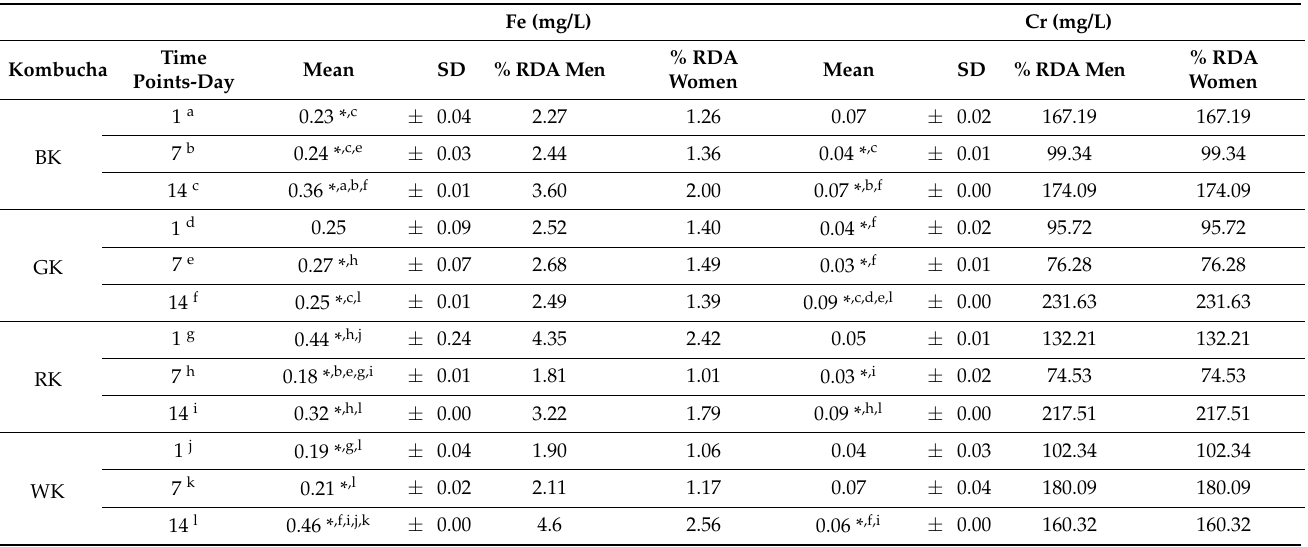
Table 3. The microminerals content (Fe, Cr) and Recommended Dietary Allowances (RDA) in